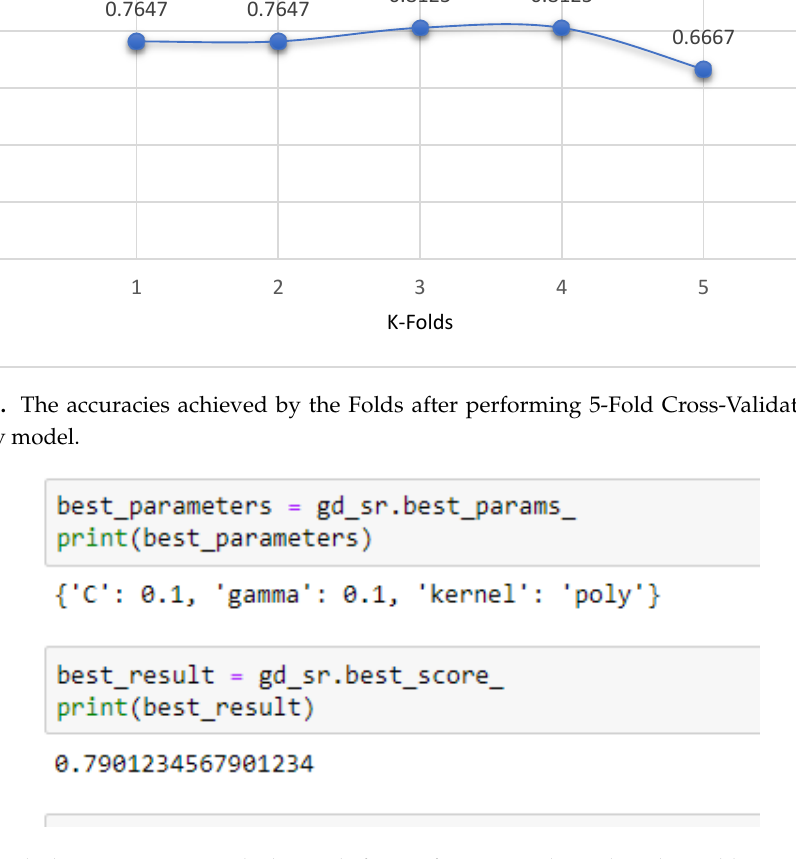
Figure 30. The best parameters with obtained after performing grid search with 5-Fold Cross-Validation on the SVM-poly model.